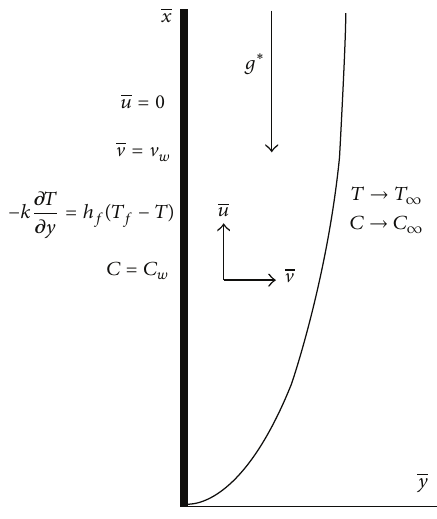
Figure 1: Physical model and coordinate